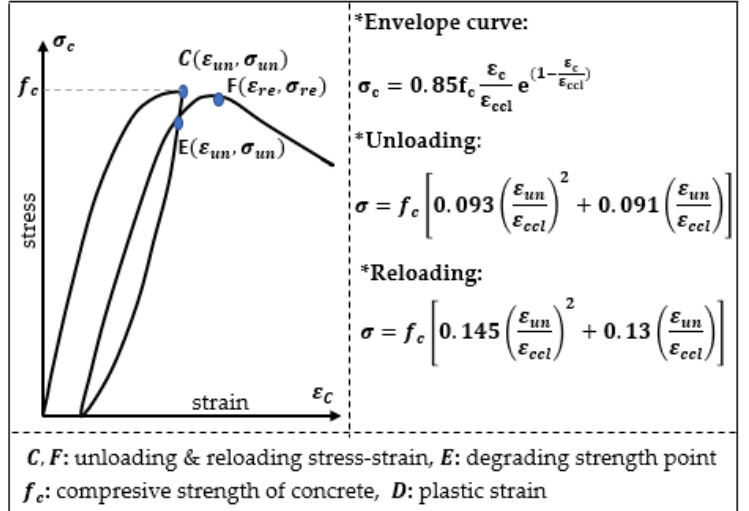
Figure 2. Concrete model according Karsan and Jirsa [3].